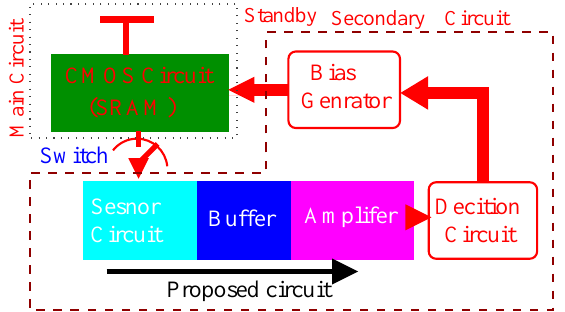
Figure 13. Proposed Compensation SRAM